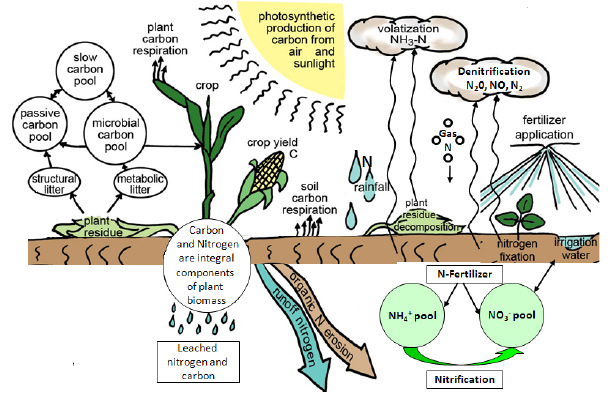
Fig. 2. USDA Farm Production